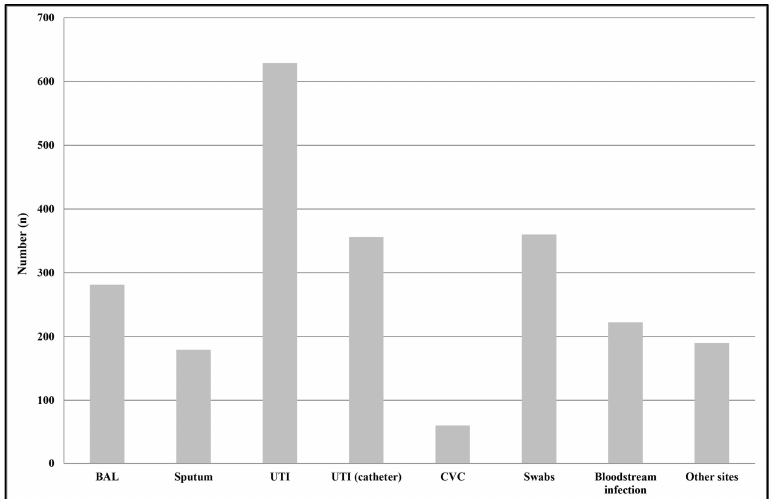
Figure 1. Distribution of Enterobacter spp. isolates by infection type. Swabs were from different anatomical sources, such as the nose, throat, groin, hears, and wounds. Other sites included samples from ascetic and peritoneal fluids. Abbreviations: BAL, Bronchoalveolar lavage; UTI, urinary tract infections; UTI (catheter), catheter-associated urinary tract infection; CVC, central venous catheter. Among outpatients, the most common specimen type from which Enterobacter